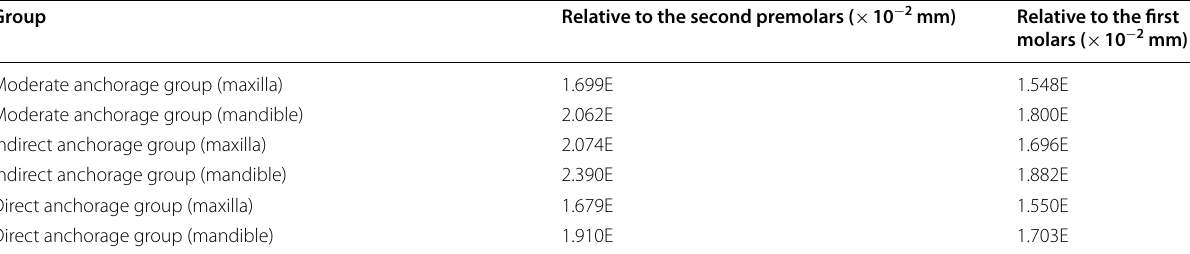
Table 4 Relative incisor extrusion in different groups